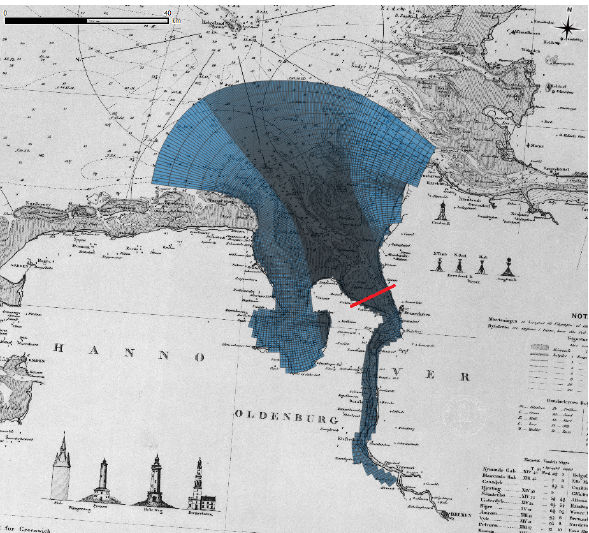
Figure 3. Model domain and grid—created on the basis of historical maps—with a background map from 1862. The cross-section 75, which is essential for the results and discussed later, is marked in red.